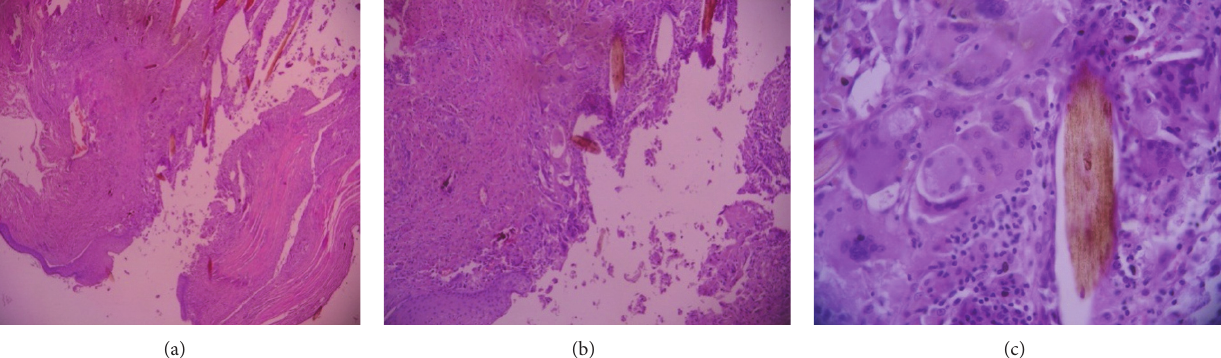
Figure 3: Hematoxylin-eosin stained slides of a specimen of pilonidal sinus obtained from the scalp of a 46-year-old patient. (a) 40, (b) 100, and (c) 400 times magnification